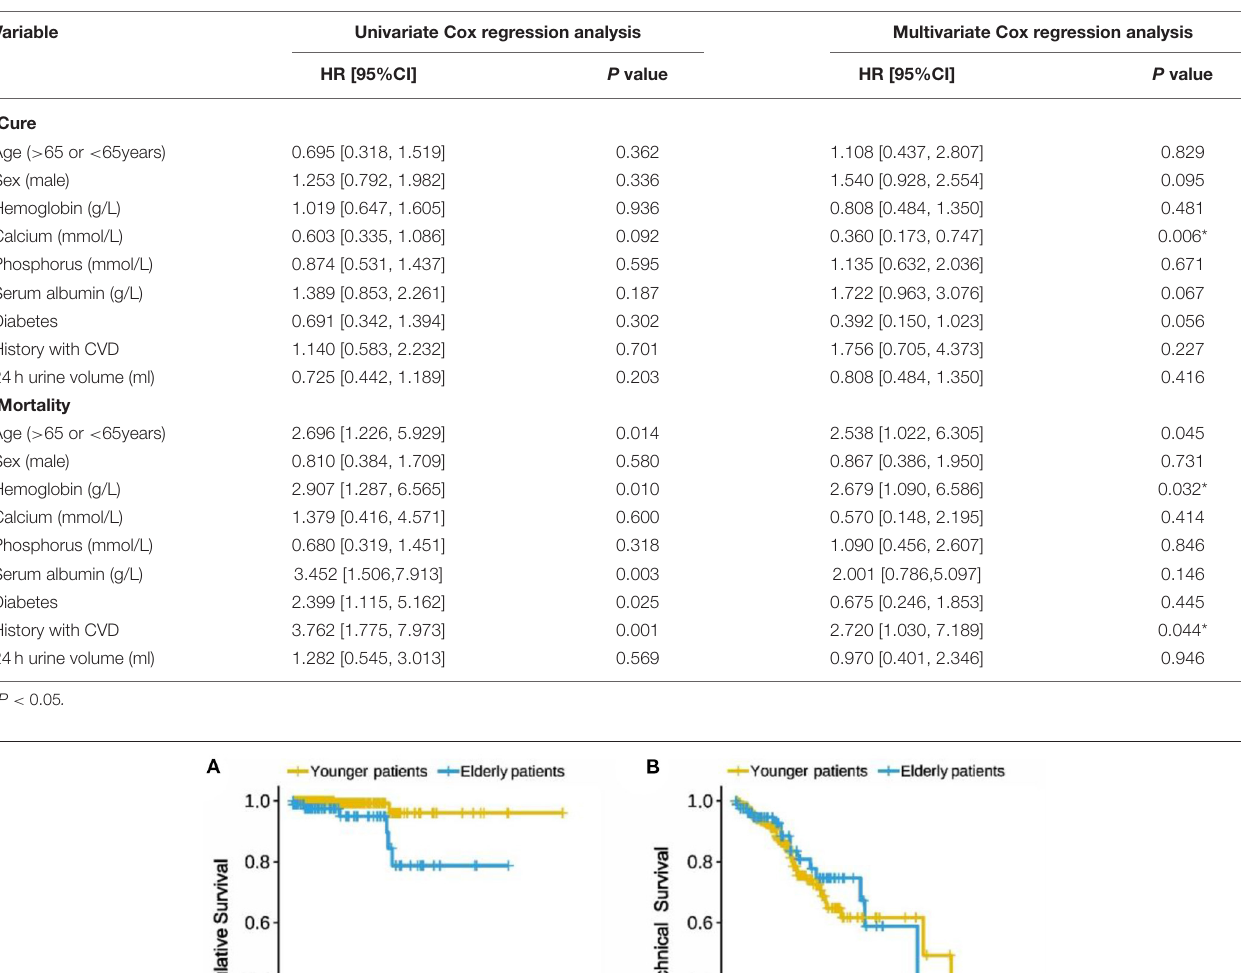
TABLE 5 | Cox proportional-hazards model for cure and mortality of PD related peritonitis.